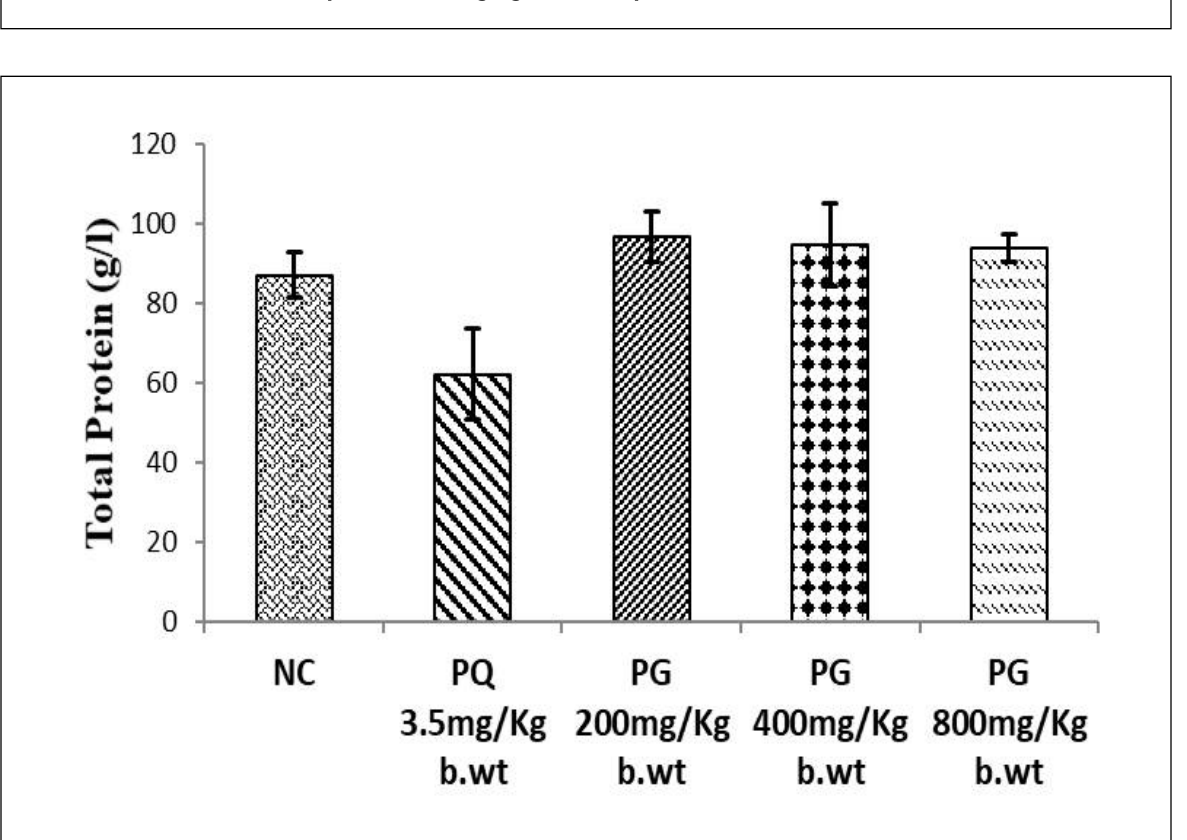
Figure 3: Effect of Psidium guajava leaf extract administration on serum total protein concentration of male Wistar albino rats administered 3.5 mg/kg b.wt.